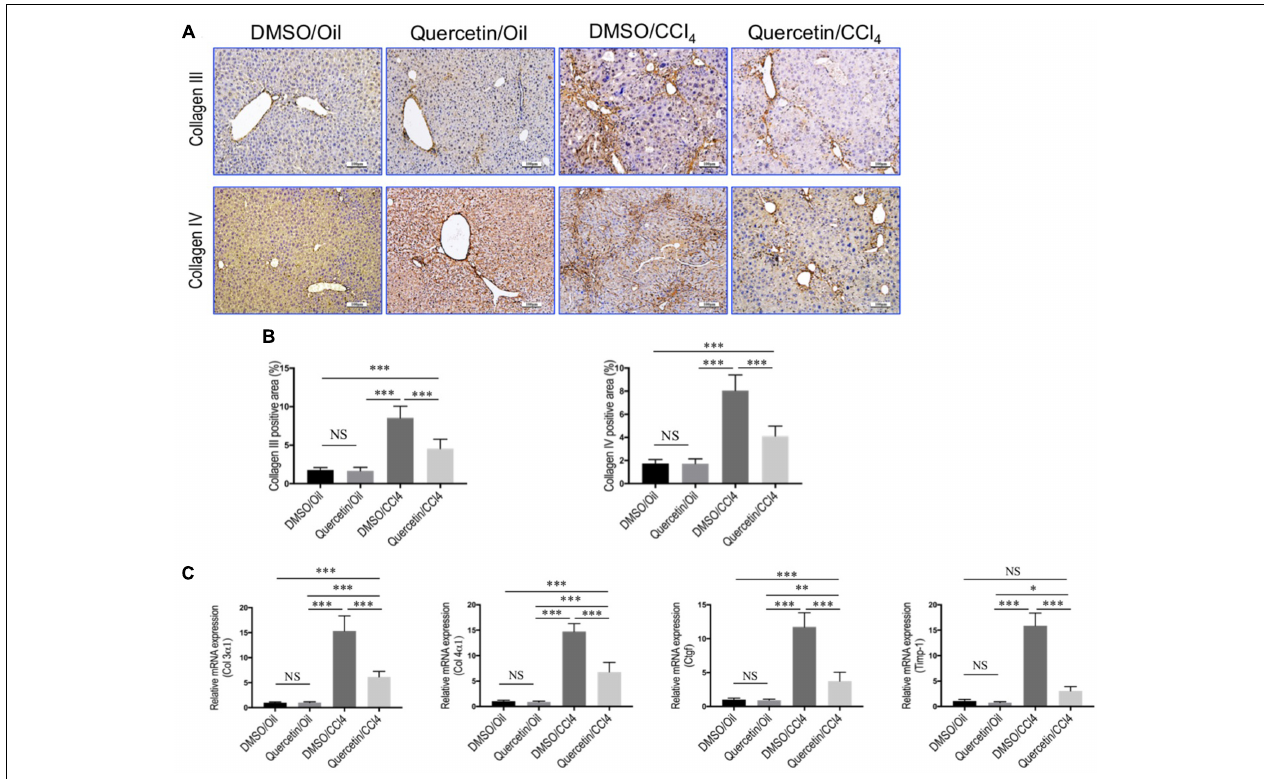
FIGURE 2 | Quercetin inhibited liver fibrotic markers expression in CCl 4 -induced mouse fibrotic liver model. (A) Representative microscopy images of Collagen III and Collagen IV immunohistochemistry in the liver (original magnification, × 100). Scale bar = 100 µ m. (B) Quantitative analysis of Collagen III- and Collagen IV-positive area by ImageJ software (NIH). n = 5/group. (C) Expression of fibrotic markers ( Col3 α 1 , Col4 α 1 , Ctgf , and Timp-1 ) was examined by quantitative RT-PCR in whole liver samples from each group ( n = 6/group). Results were normalized to GAPDH mRNA and expressed as fold change compared to DMSO/oil mice. ∗ P < 0.05, ∗∗ P < 0.01, ∗∗∗ P < 0.001; “NS” indicates not